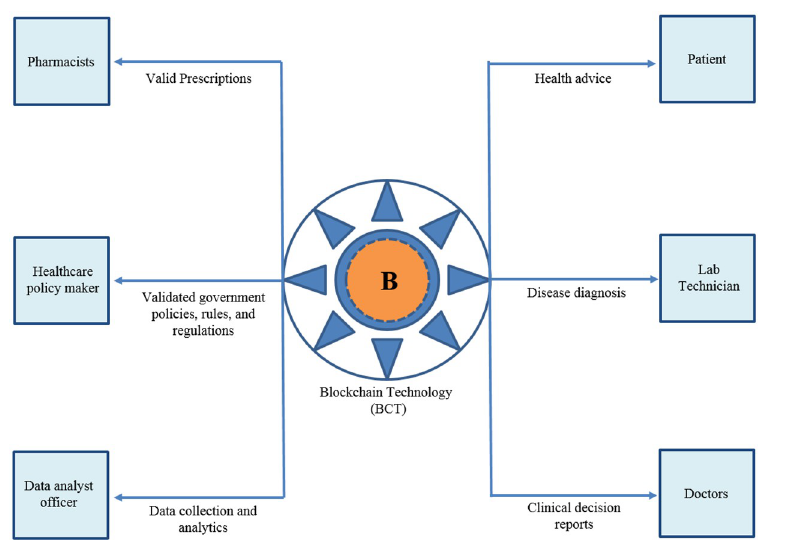
Fig 7. Sharing health information using BCT.